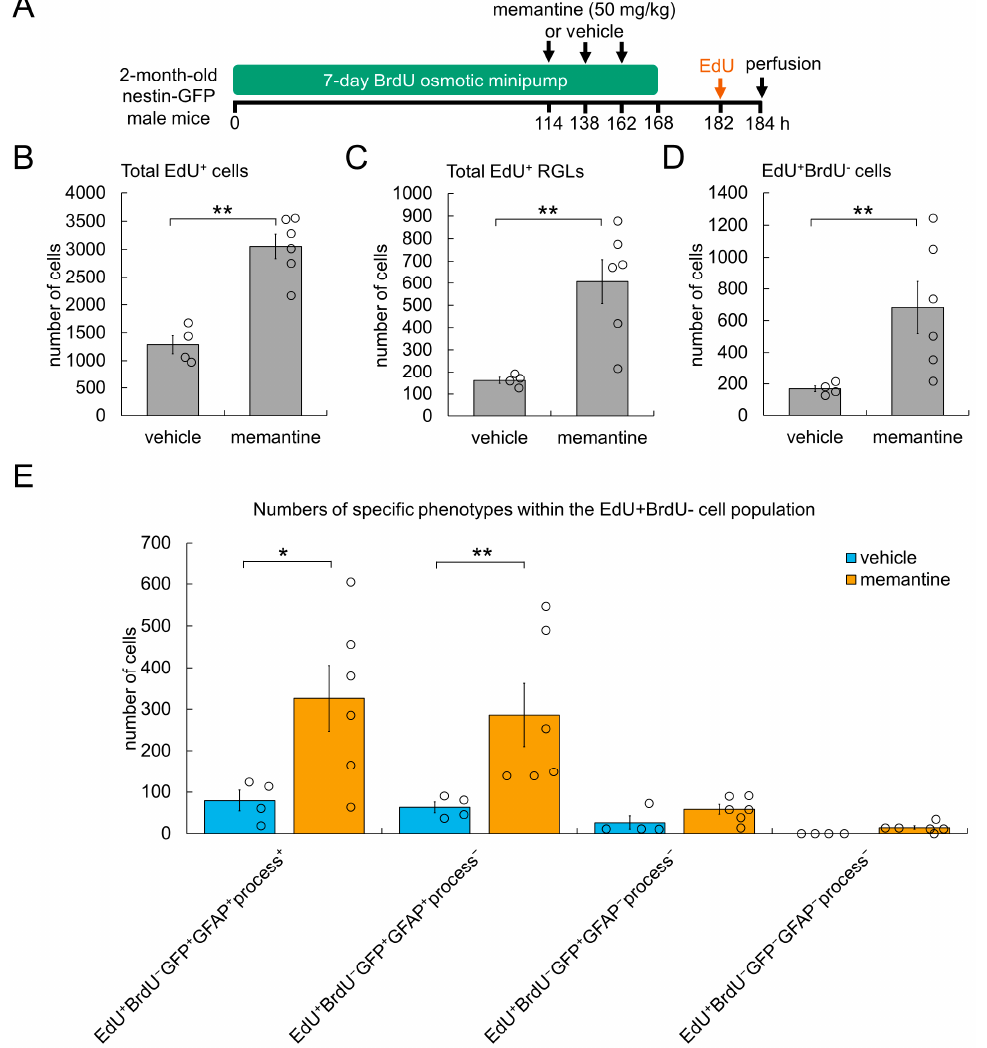
Figure 3. Memantine enhances proliferation in the DG of the adult brain via recruitment of quiescent RGL stem cells. ( A ) Scheme of the experiment, demonstrating delivery of two labels and treatment with memantine. Memantine significantly induces proliferation ( B ) and increases the numbers of proliferating RGLs ( C ) and de novo dividing cells ( D ) in the DG. ( E ) Phenotyping of EdU ⁺ BrdU ⁻ cells, indicating that memantine significantly increases the numbers of de novo dividing bona fide (GFP ⁺ GFAP ⁺ process ⁺ ) and presumptive (GFP ⁺ GFAP ⁺ process ⁻ ) RGLs. Quantitative data are pre- sented as mean ± SEM. Statistics: vehicle n = 4, memantine n = 6; Mann–Whitney test, * p < 0.05, ** p < 0.01.